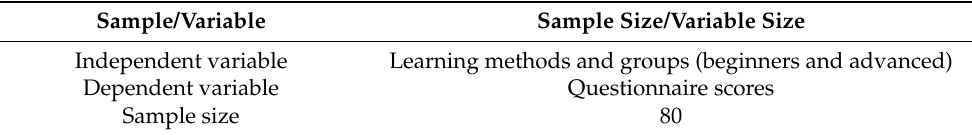
Table 5. Sample and variable size used for the study.